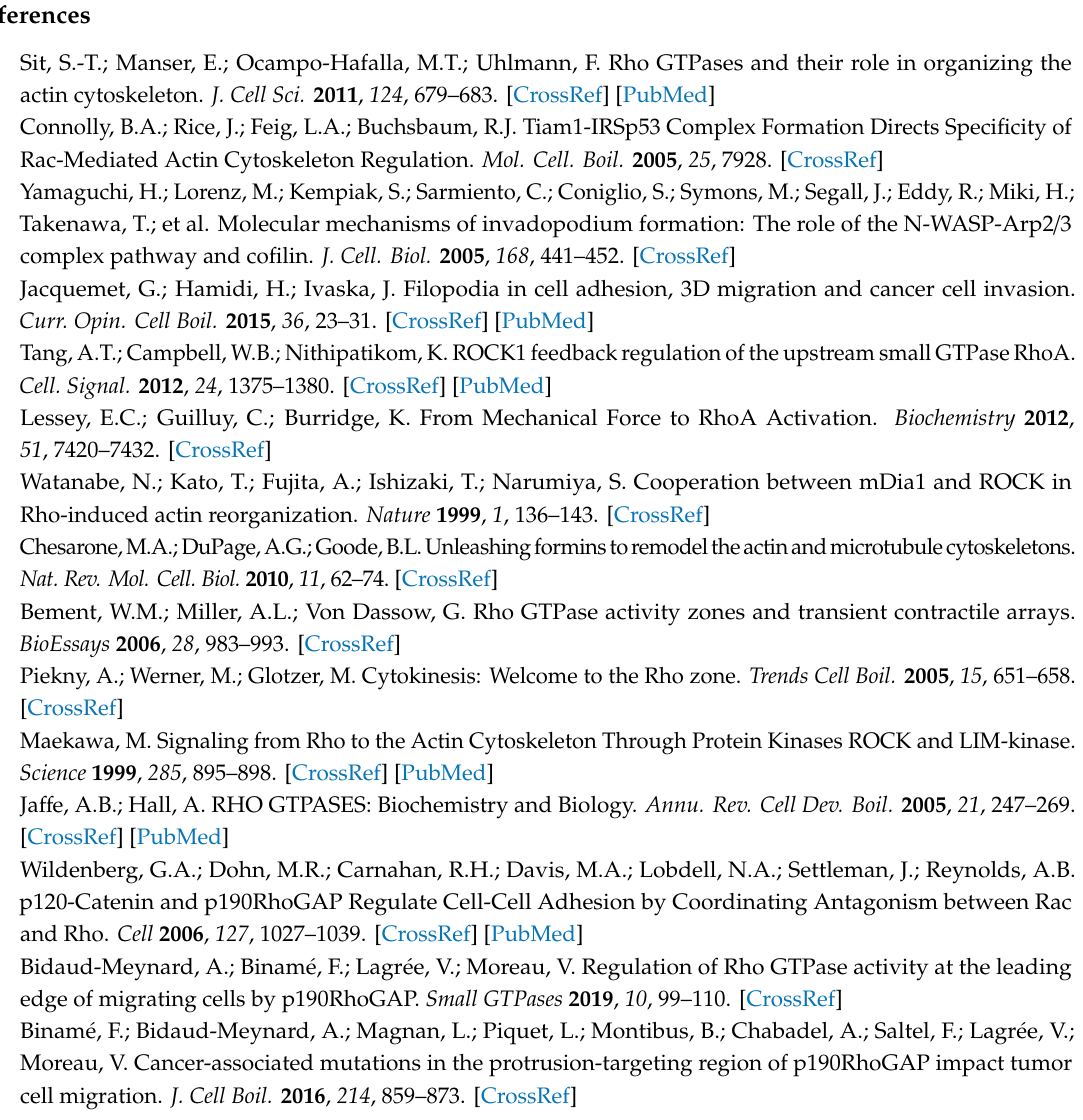
Figure S1: pMLC abundance decreases in the absence of Arp2 / 3 complex. Figure S2: YAP-ARHGAP29 regulates RhoA activity. Figure S3: The abundance of Rac1 & Cdc42 did not change after CK-666 & SMIFH2 treatment. Author Contributions: C.W. and Y.H. conceived the project and designed the experiments. Y.H. and X.Y. performed the imaging experiments and data analysis. Y.H. constructed stable cell lines. C.K. assisted